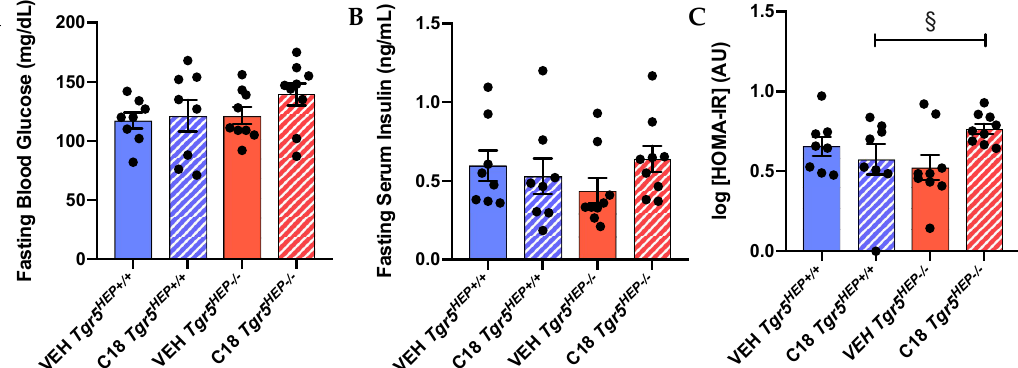
Figure 4. Compound 18 improves insulin sensitivity in a hepatocyte TGR5-dependent manner. ( A ) Fasting blood glucose, ( B ) fasting serum insulin concentrations, and ( C ) log(HOMA-IR) in Tgr5 HEP +/+ and Tgr5 HEP − / − mice after 3 doses of Compound 18 (C18) or vehicle (VEH). n = 8–9. § p < 0.05 compared with Compound 18 Tgr5 HEP +/+ by one-tailed Student’s t -test.